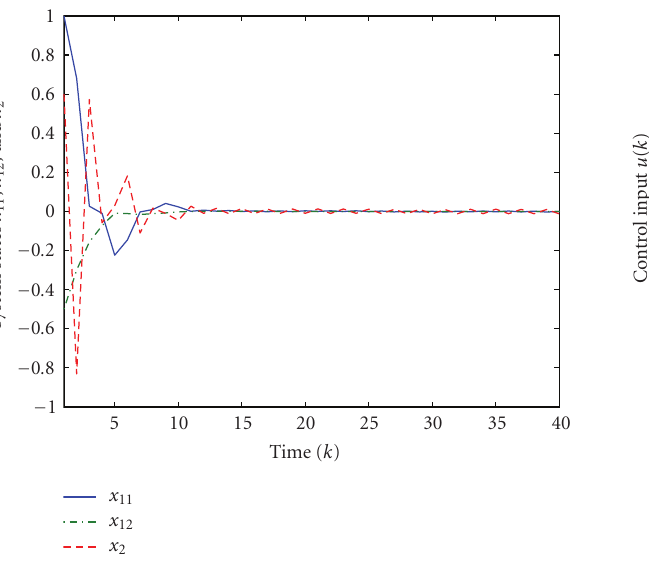
Figure 2: System states x 11 , x 12 , and x 2 .